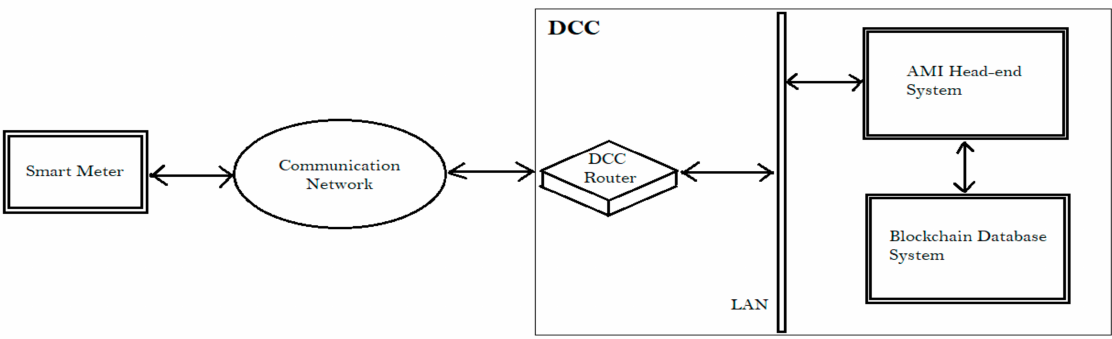
Figure 5. Blockchain-based AMI. DCC: data and control center.